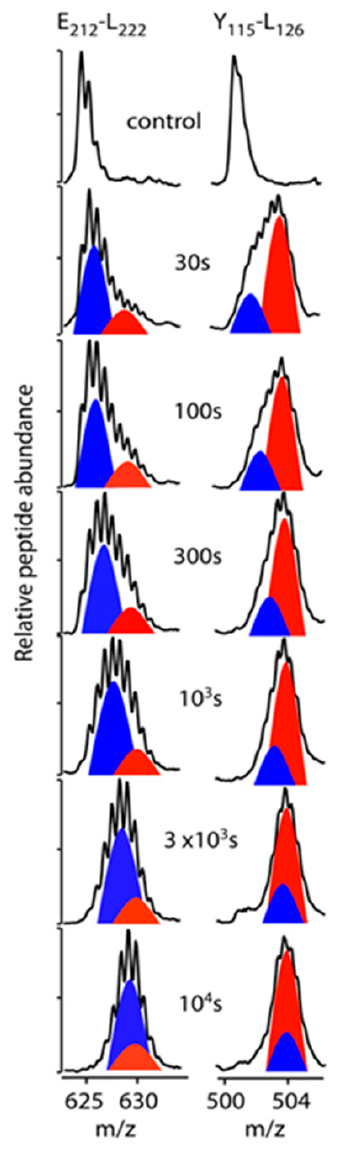
Figure 2. Bimodal hydrogen-deuterium exchange (HDX) kinetics in apolipoprotein A-I (apoA-I) in rsHDL. The change in the shape of the MS peak of a digested peptide as a function of the HDX reaction time was an indication that the protein domain, corresponding to the digested peptide, existed in di ff erent conformations or experienced di ff erent interaction environments in the folded protein. Left : The MS spectra of peptide E 212 DLRQGLLPVL 222 at various HDX times suggested that the corresponding protein domain in the intact protein existed in two distinct conformations, one in which the amide H was better protected from HDX, for example, in an alpha-helical arrangement, leading to a slow H to D exchange (blue peak), and a second conformation in which H was replaced by D much faster (red peak). The di ff erence in HDX rates between the two domains led to a characteristic shape for the MS peak, a shape that also depends on the abundance of the two conformations. In this case, the fast exchanging protein domain produced a peptide abundance (red peak) about half of the slow H / D exchanging domain. Right : Bimodal HDX kinetics is shown for the case of a slow H / D exchanging peptide (blue peak, Y 115 RQKVEPLRAEL 126 ) that had a peptide abundance about half of the fast H / D exchanging peptide (red peak). The MS spectra for each peptide and the peptide peaks showed that the centroids ( m / z ) for each “peak” (red / blue cartoons) were gradually merging at longer HDX times (10 4